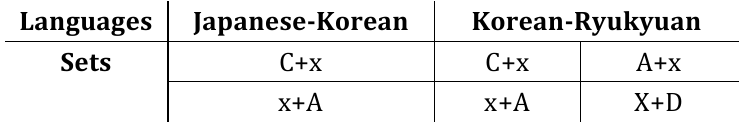
Table 13: Sets that show significant